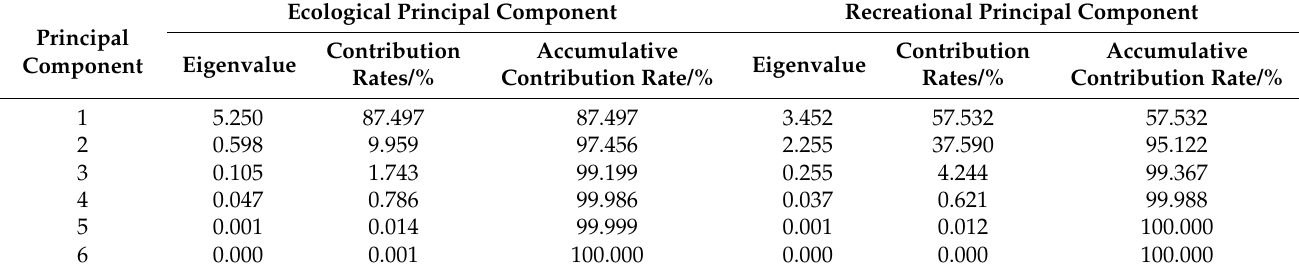
Table A2. Statistical table of variance